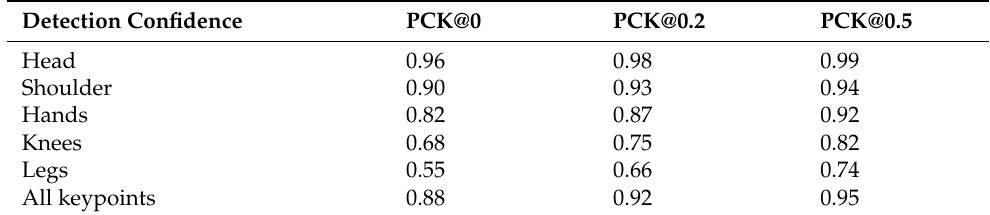
Table 2. Summary of PCK values when thresholding at different detection confidence rates.